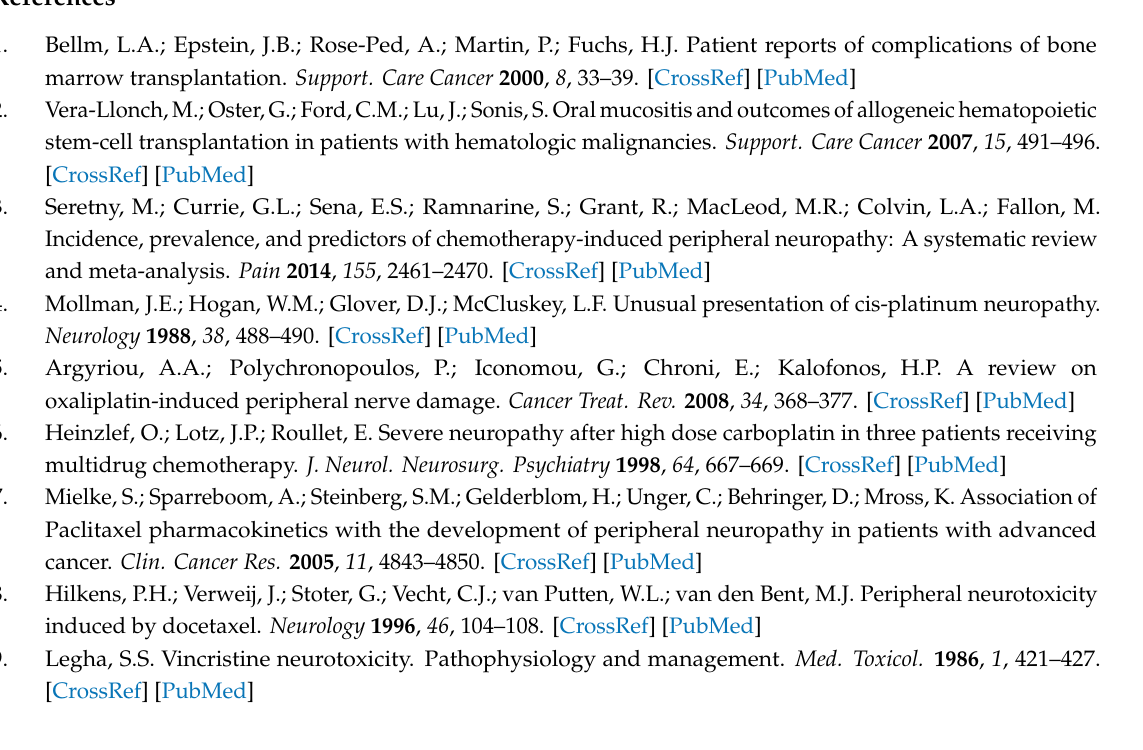
Table S1: Tumor specificity of 291 compounds; Table S2: Radical scavenging and monoamine oxidase inhibitory and cholinesterase inhibitory activities of chromones, esters, and amides; Table S3: Test for anti-HIV activity of chromones, esters, and